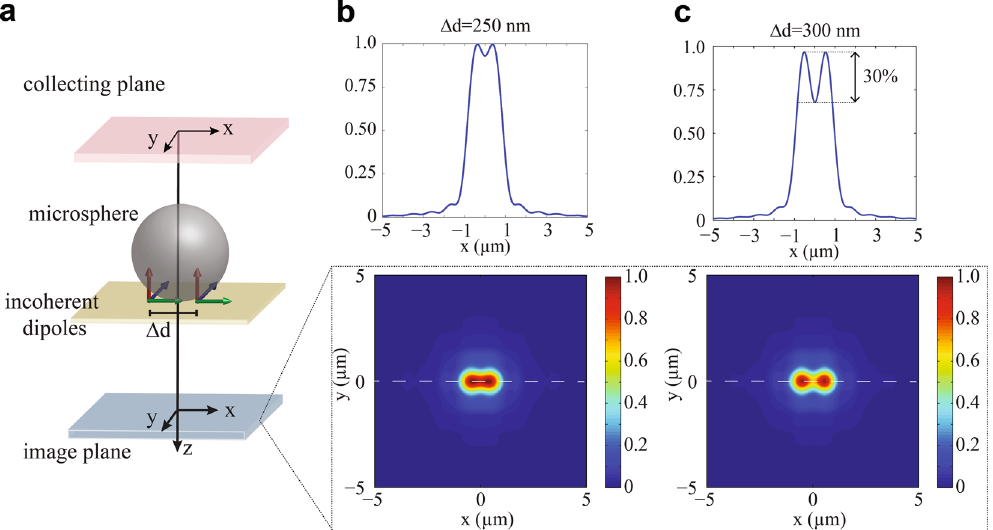
Figure 3. FDTD simulations of a model system for microbead image formation. ( a ) Scheme of the simulated layout, with two incoherent dipoles placed in contact with the microbead and separated a distance Δ d. The electromagnetic field generated by the dipoles is calculated in the collecting plane and back-propagated. The position of maximum intensity is considered the image plane. ( b ) Normalized intensity profile and corresponding intensity colormap for two dipoles separated 250 nm and ( c ) 300 nm. Only the latter can be